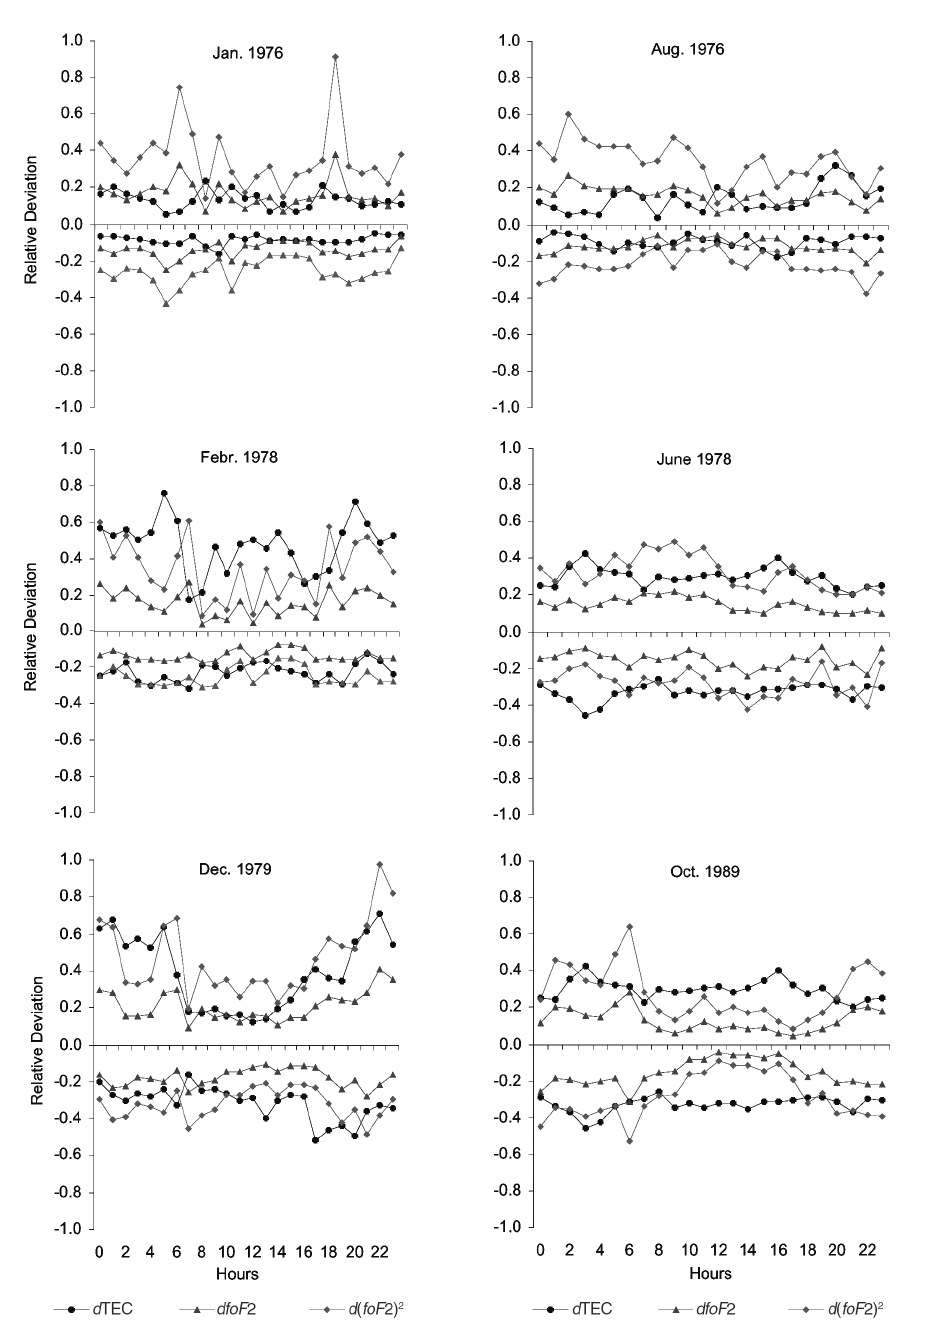
Fig. 9.2a. Upper and lower deciles in TEC, foF 2 and ( foF 2) 2 . Faraday rotation data have been used.